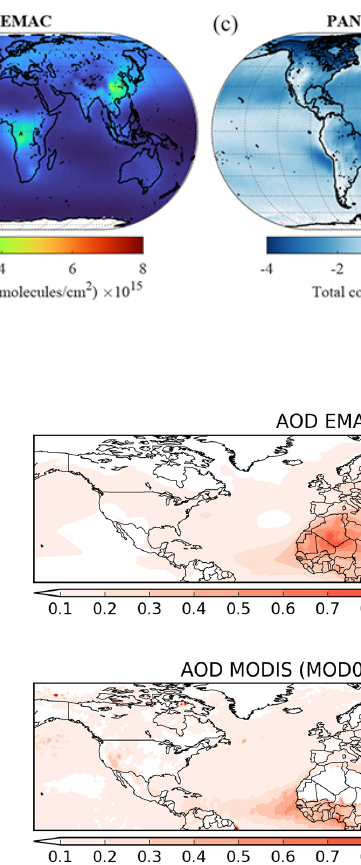
Figure 16. Global map of AOD from model results and the MODIS observations for the year 2010 (annual